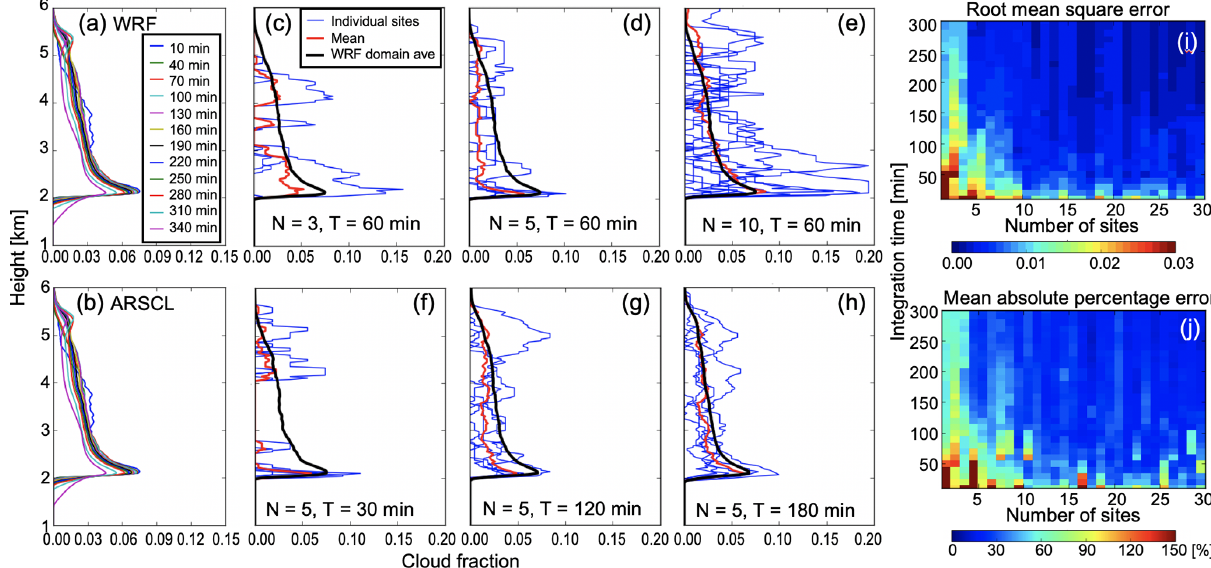
Figure 7. Investigation of errors of cloud fraction profiles (CFPs) from profiling measurements. CFPs from single sites are estimated by integrating over time and then averaged. Shown are domain-averaged cloud fraction profiles (CFPs) from (a) WRF-simulated cloud water mixing ratio and (b) the simulated ARSCL product for a shallow convection case on 11 June 2016. Colors in (a) and (b) represent different integration time periods centered at 21:00:00UTC. The minimum threshold for the WRF cloud water mixing ratio is 0.01gkg − 1 . (c–h) CFPs from the simulated ARSCL with different number of observation sites N and different integration periods T. The black line in (c–h) represents the domain-averaged CFP from the WRF-simulated cloud water mixing ratio, blue lines represent CFPs from individual observation sites, and the red line represents the mean CFP from averaging over the individual sites. (i, j) Root mean square error (i) and mean absolute percentage error (j) of the simulated ARSCL CFPs as a function of the number of observation sites and integration